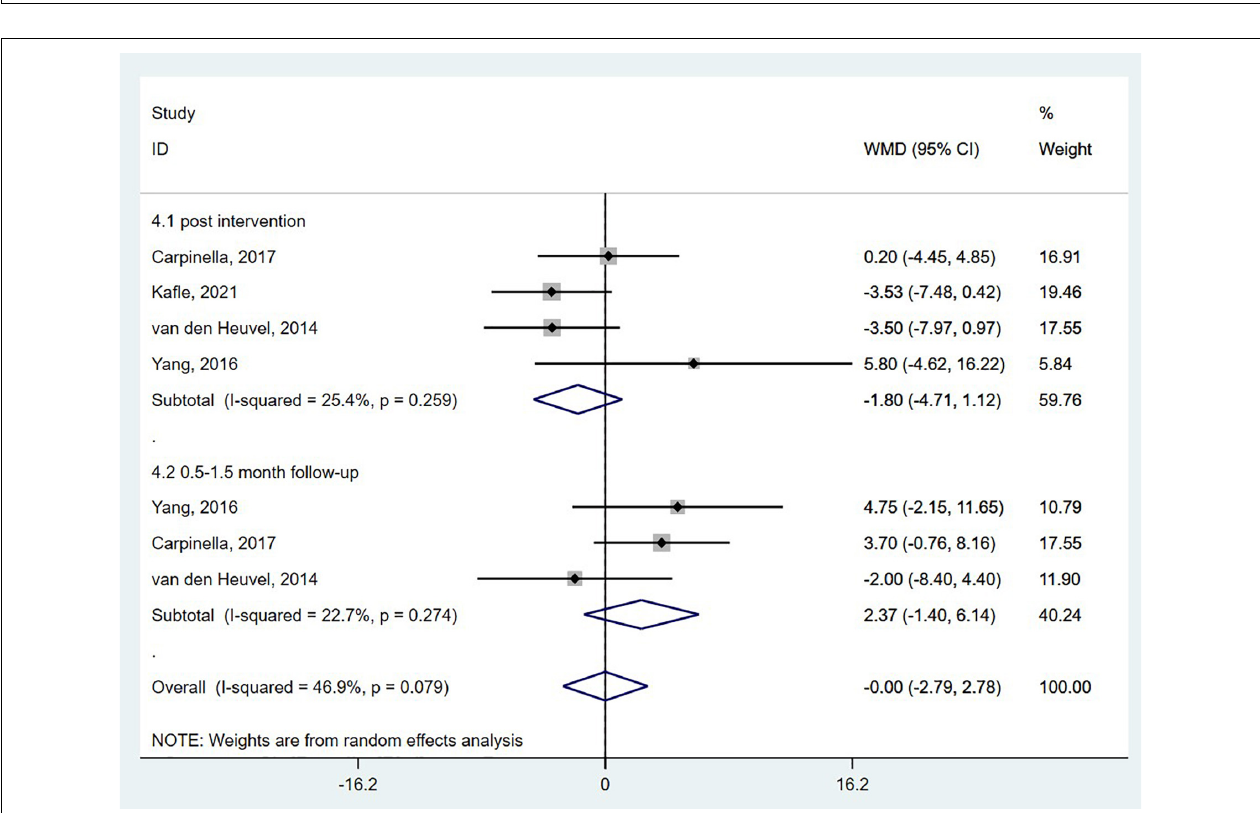
FIGURE 4 | Forest plot of pooled results for Unified Parkinson’s Disease Rating Scale-III.